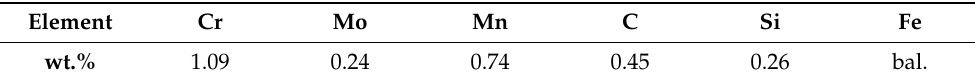
Table 1. Chemical composition of 42CrMo4 steel adapted with permission from ref. [28]. Copyright